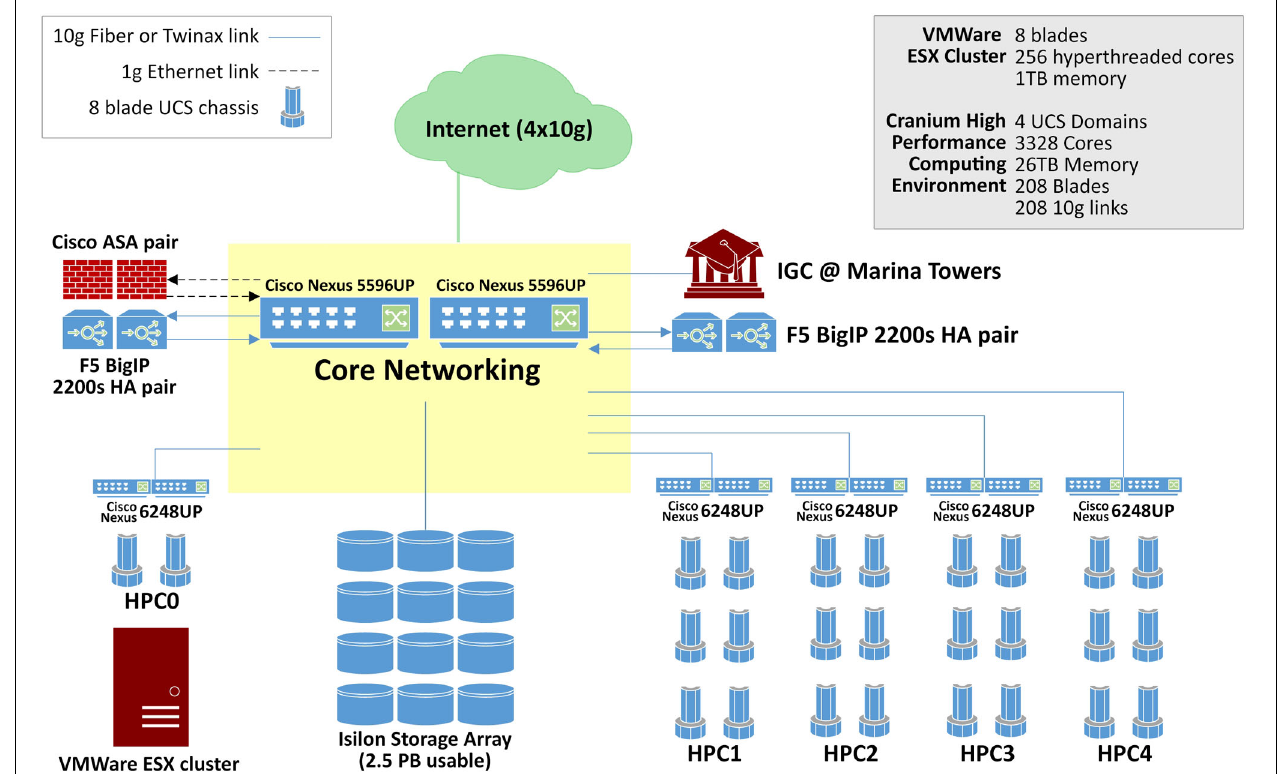
FIGURE 1 | LONI/INI network infrastructure and supercomputing